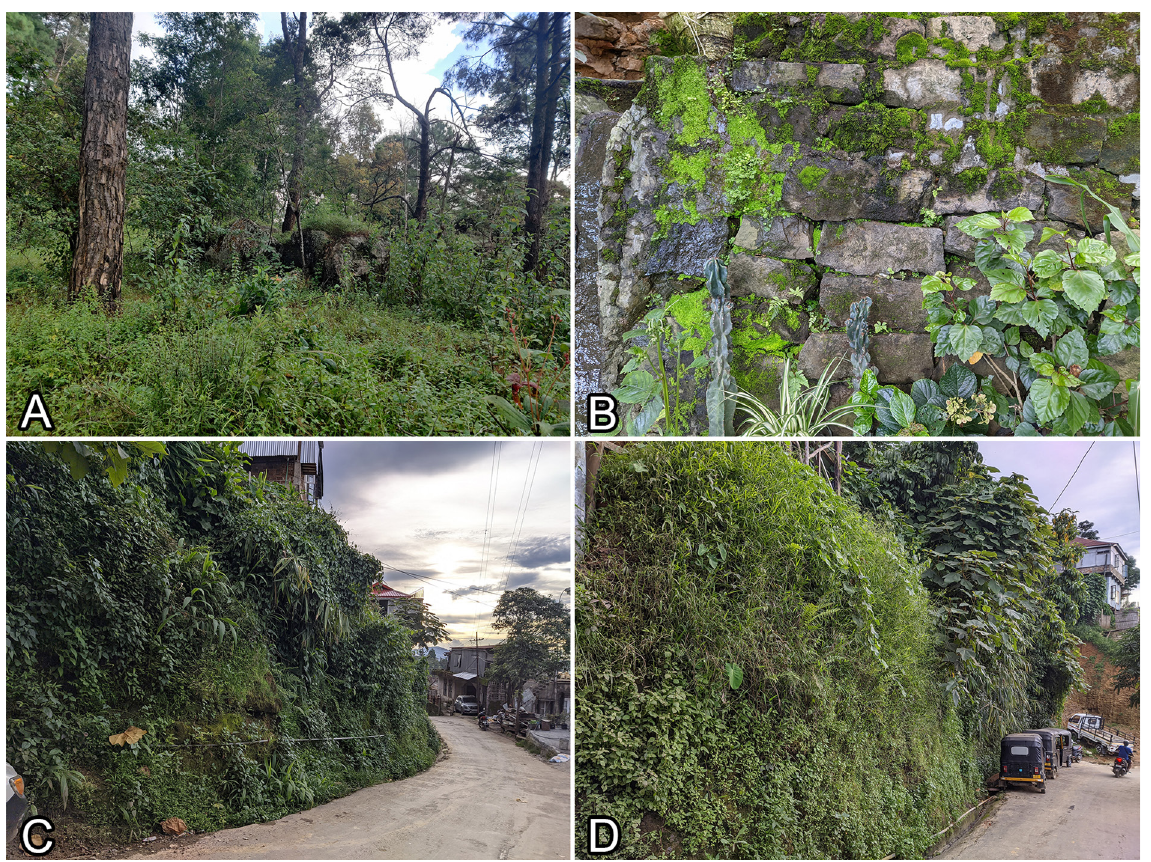
Fig. 7. Microhabitats showing the collection sites of our newly described species of Cyrtodactylus from Northeast India. A . Collection site of Cyrtodactylus exercitus sp. nov. in Umroi military cantonment area, Ri-Bhoi district, Meghalaya state. B – D . Collection sites of C. siahaensis sp. nov. in Siaha town, Siaha district, Mizoram